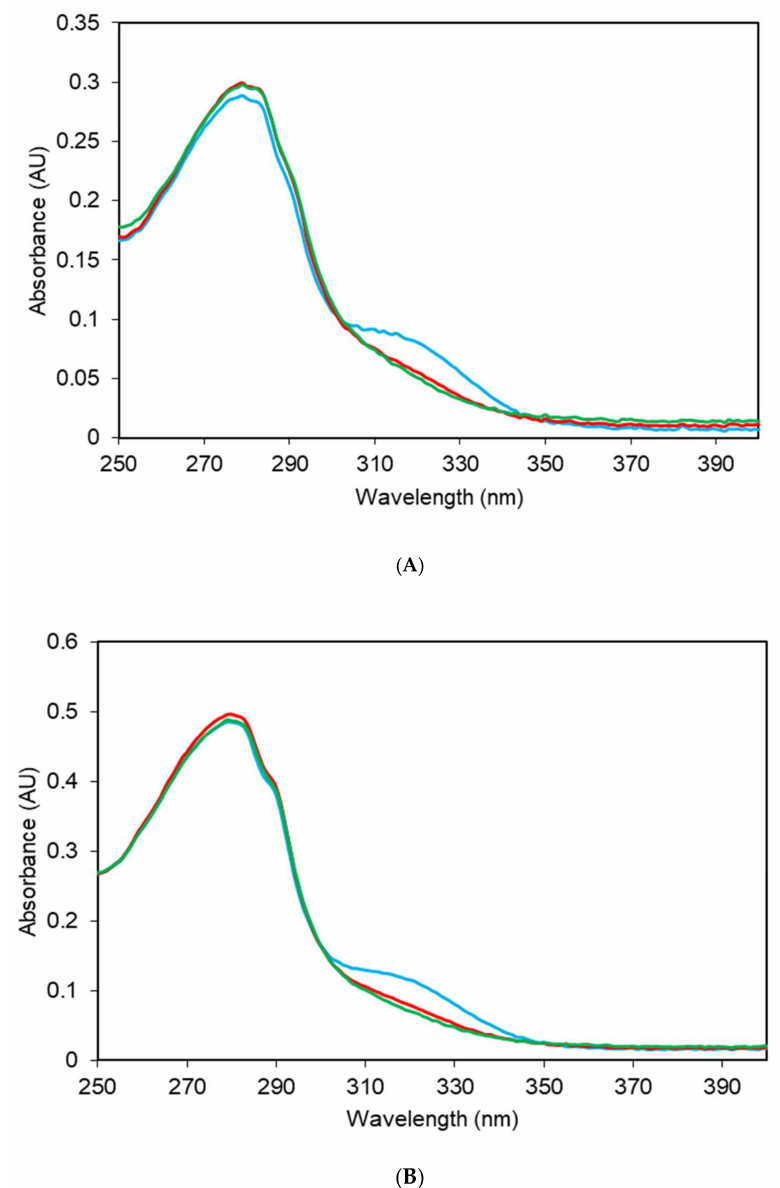
Figure 2. ZnT8c UV absorbance changes with addition of zinc. Representative (n = 3) UV absorbance spectra of 35 µ M of ZnT8cR ( A ) and ZnT8cW ( B ) in the absence of Zn 2+ (blue), and with one (red) and two (green) molar equivalents of Zn 2+ , demonstrating that addition of Zn 2+ ablates a broad peak at approximately 320 nm from both apo-ZnT8c variants. Spectra are buffer- and dilution-corrected. Table 1. Metal analysis (inductively coupled plasma-mass spectrometry (ICP-MS) of zinc and nickel content of 2 µ M monomeric ZnT8cR after gel filtration following incubation with 0–10 molar equivalents of Zn 2+ (n = 3). Mol. Equiv. Zn